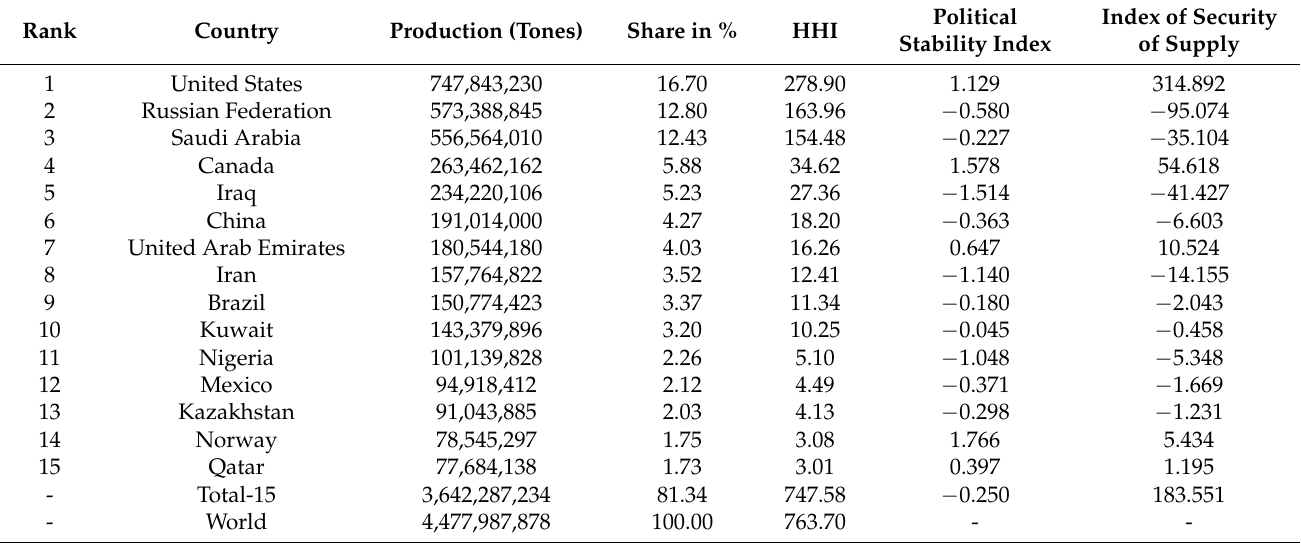
Table 3. Herfindahl-Hirschman index, index of security of supply and crude oil production in